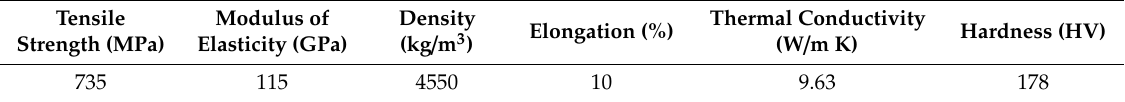
Table 1. Mechanical properties of the Ti-2.5Al-2Mn alloy [43].